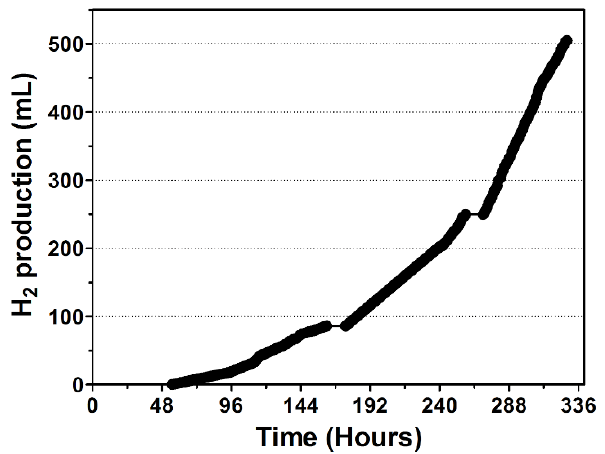
Figure 5. H 2 production by immobilized Rhodopseudomonas sp. cells in calcium alginate beads immersed in the cylindrical photobioreactor. Immobilized cells were washed and retested for their capacity to produce H 2 at 165 and 264 h.